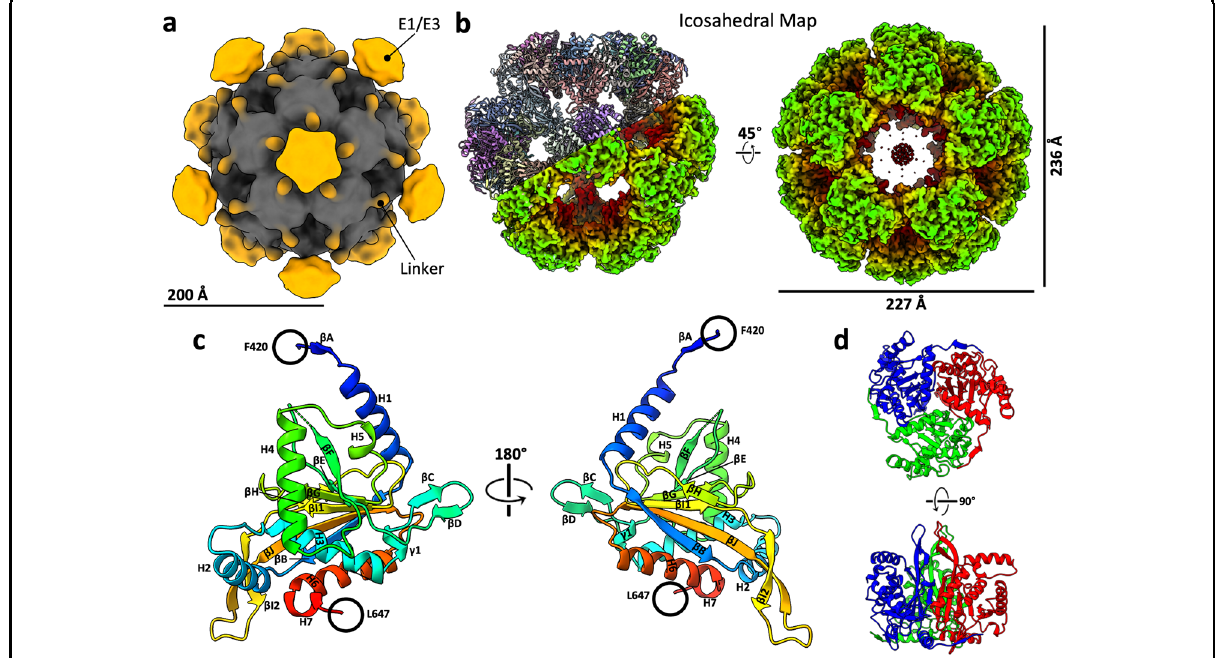
Fig. 3 Cryo-EM reconstructions of bovine PDC and atomic structure of native E2p IC domain. a 3D reconstruction of the full PDC with icosahedral symmetry shows external densities (orange) around the core density (gray). b Two views of the cryo-EM density map of E2p core colored by radius, with our E2p atomic model assembly of a hemisphere shown in the left panel. c Rainbow-colored ribbon of E2p IC domain atomic model with secondary structures labeled. Resolvable N-terminal residues (blue) and C-terminus (red) are indicated. d Two views of the atomic model of the E2p IC domain trimer, colored by